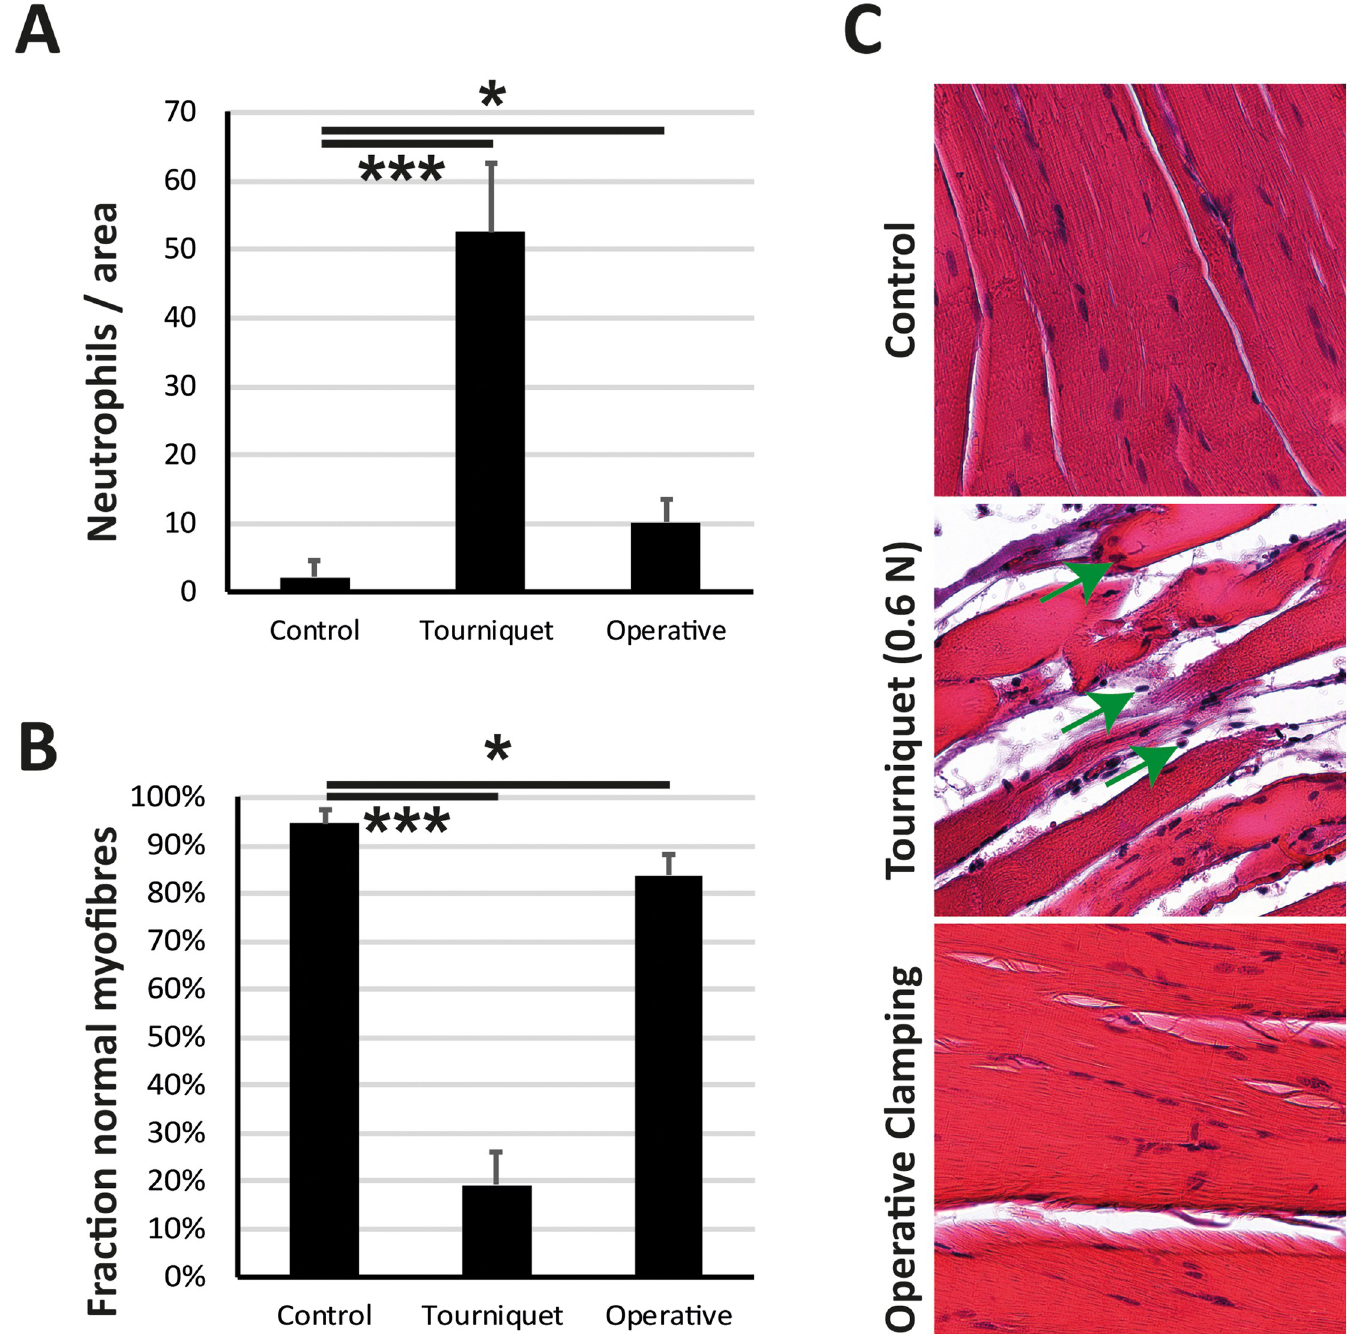
Fig 5. Low-pressure tourniquet leads to destruction of muscle fibers and neutrophil infiltration. After ischemia of 2 hours and reperfusion of 4 hours (A) Neutrophils per 2000 × 2000 Pixels were measured. The low-pressure tourniquet led to a significant increase in neutrophil infiltration compared to control (sham) animals. The operative clamping of the femoral artery did not show the same significant increase in neutrophil infiltration. (B) Fraction of normal myofibers was significantly lower in the tourniquet cohort compared to control and operative clamping. (C) Histological images at a magnification of 100 × showed a higher neutrophil infiltration (neutrophils are marked with a green arrow) in the tourniquet group compared to control and operative clamping. Results are shown as means ± SEM. P- value: � < 0.05; ��� < 0.001; (ANOVA), n = 4.